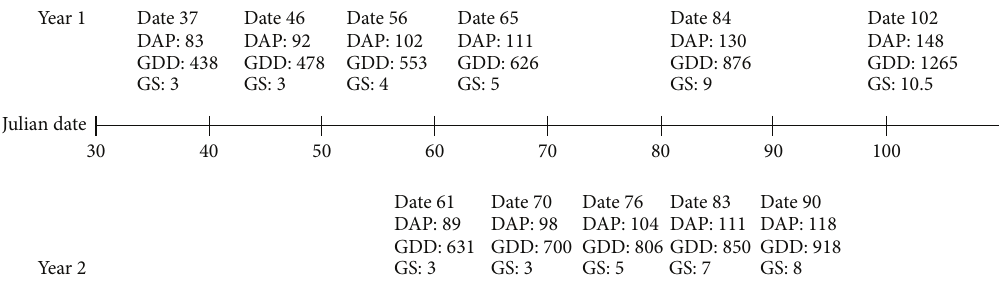
Figure7:Accumulateddaysafterplanting(DAP),growingdegreedays(GDD),andobservedFeekesgrowthstage(GS,forvarietyAroostook) at successive sampling dates (Julian dates) for year one and year two of the field experiment.